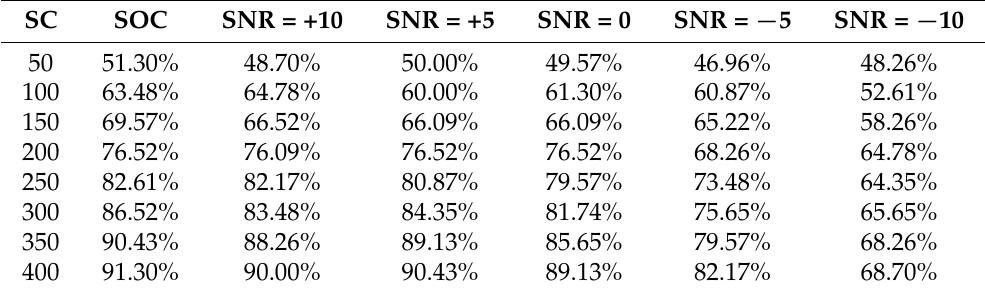
Table 6 details the accuracy obtained from each set of models for SNRs. Table 6. Extended Operating Condition—Percentage of Correct Classification (PCC) for different SNR resulting from noise